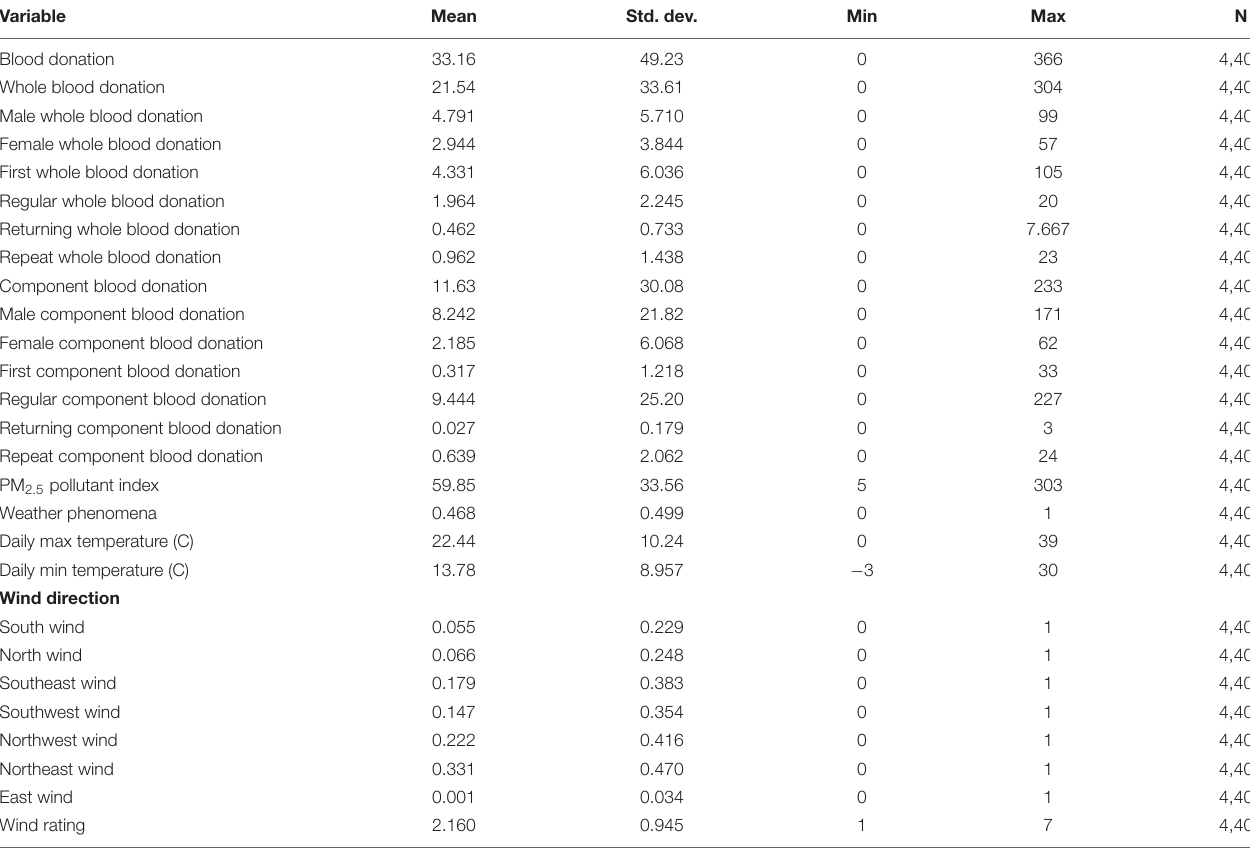
TABLE 2 | Summary statistics of some key variables.